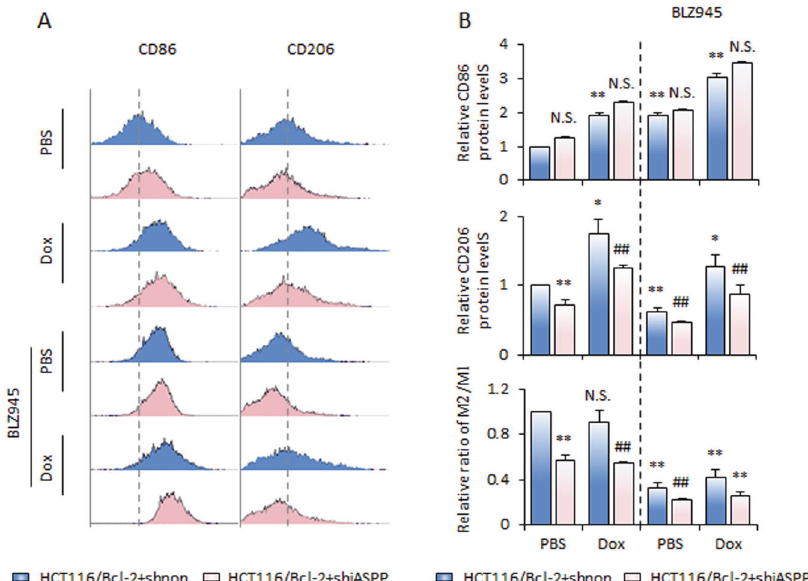
Fig. 6 iASPP-Nrf2-M-CSF regulates M2 polarization in vivo. A , B Expression levels of CD86 and CD206 were detected by fl ow cytometry in the indicated xenografts. The representative images are shown in A and the quanti fi cation and the ratio of M2/M1 (CD206/CD86) are shown in B . Values are mean ± SD from three independent experiments; * P < 0.05, ** P < 0.01, compared with PBS ( B ); ## P < 0.01, compared with Dox and/or BLZ945-treated control ( B ); N.S., not signi fi cant ( B